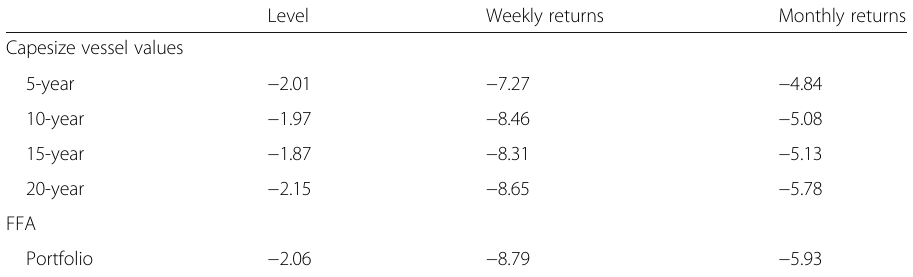
Table 3 Augmented Dickey Fuller (ADF) test